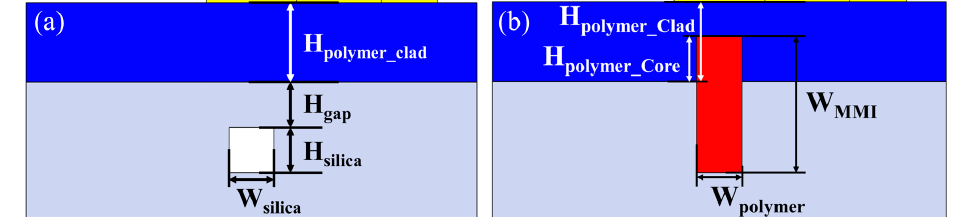
Figure 2. Cross-section of ( a ) silica waveguide and ( b ) polymer MMI.